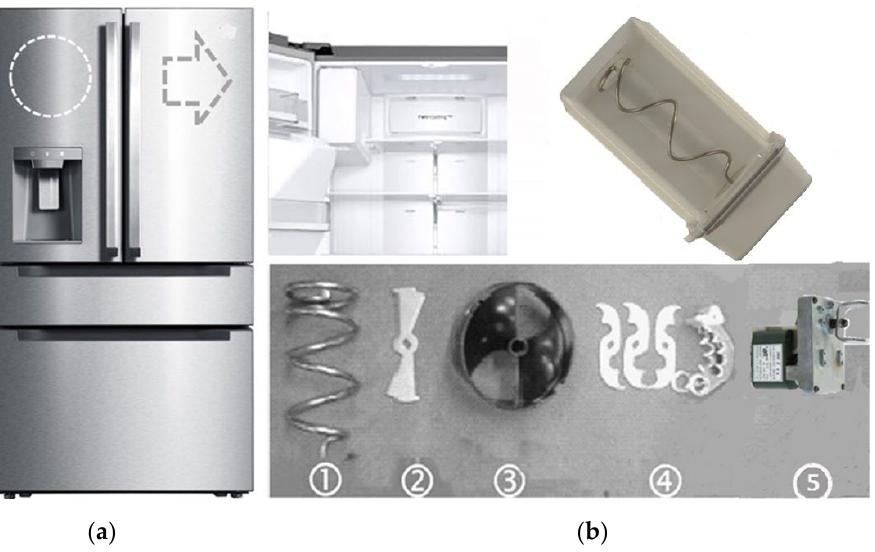
Figure 7. A domestic refrigerator with ice-maker. ( a ) French-door refrigerator; ( b ) machine compo- nents in an ice-maker: helix support 1 (cid:13) , blade dispenser 2 (cid:13) , helix upper dispenser 3 (cid:13) , blade 4 (cid:13) , and auger motor 5 (cid:13)